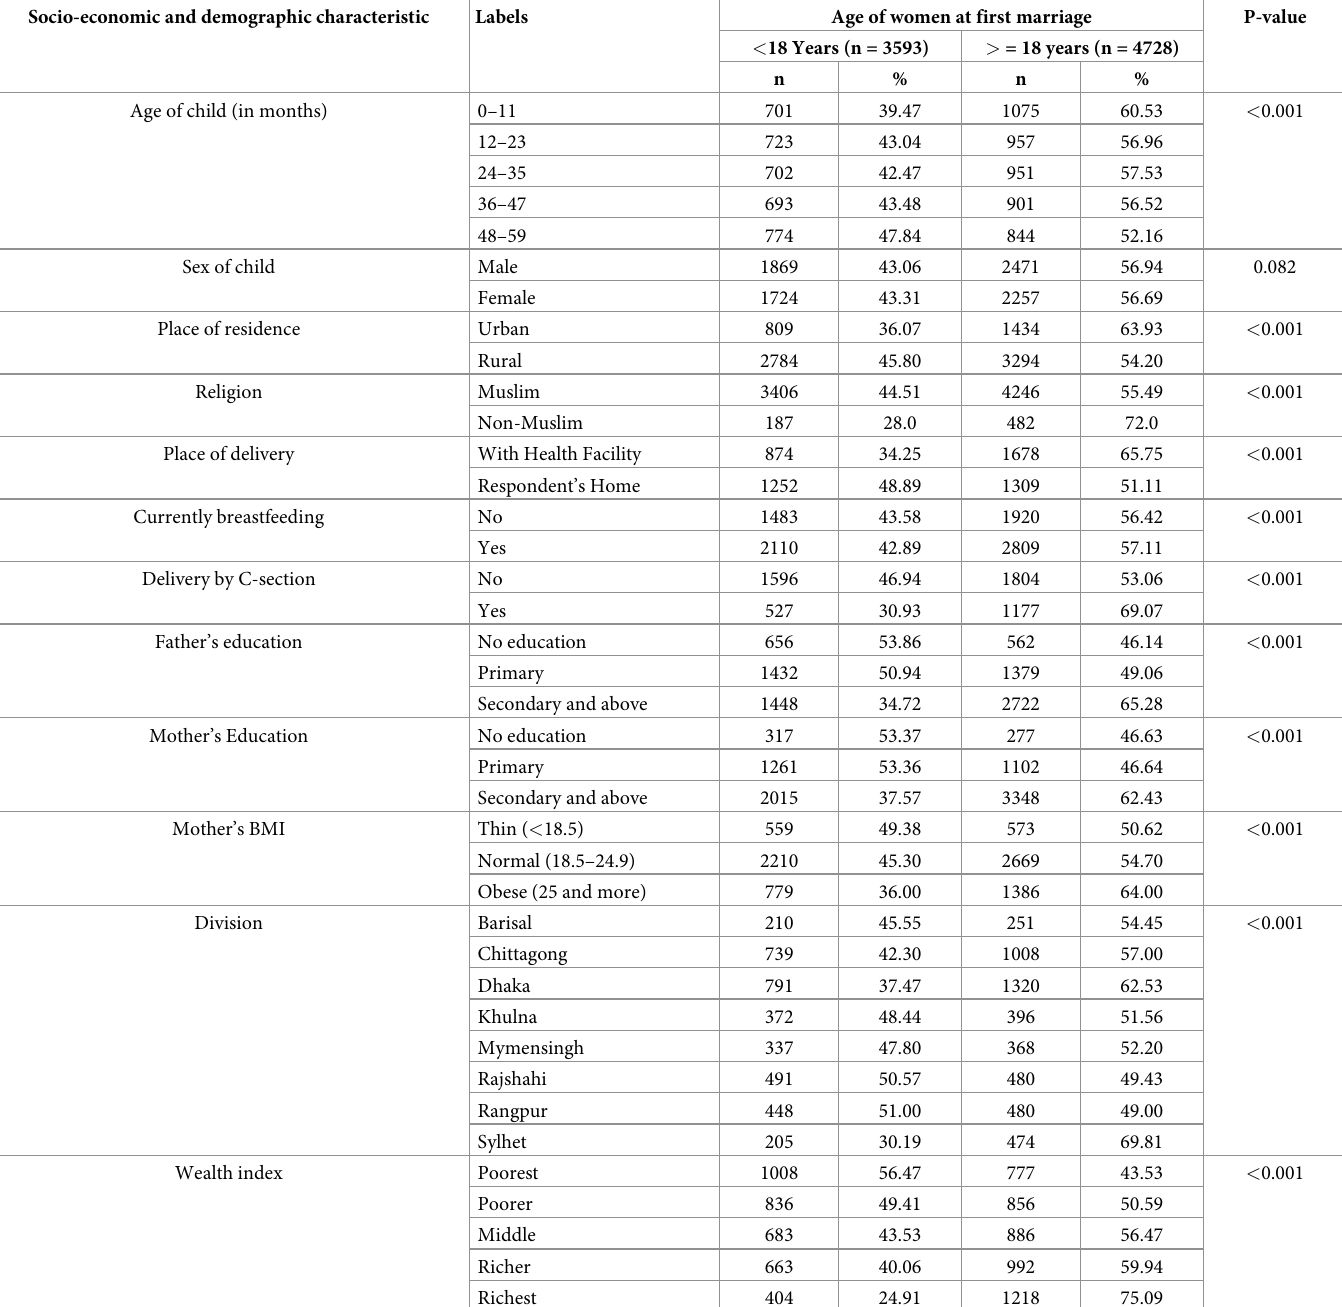
Table 1. Socio-economic and demographic characteristics by child marriage ( < 18 years) and adult marriage ( > = 18 years) in Bangladesh, BDHS-2017-18. Socio-economic and demographic characteristic